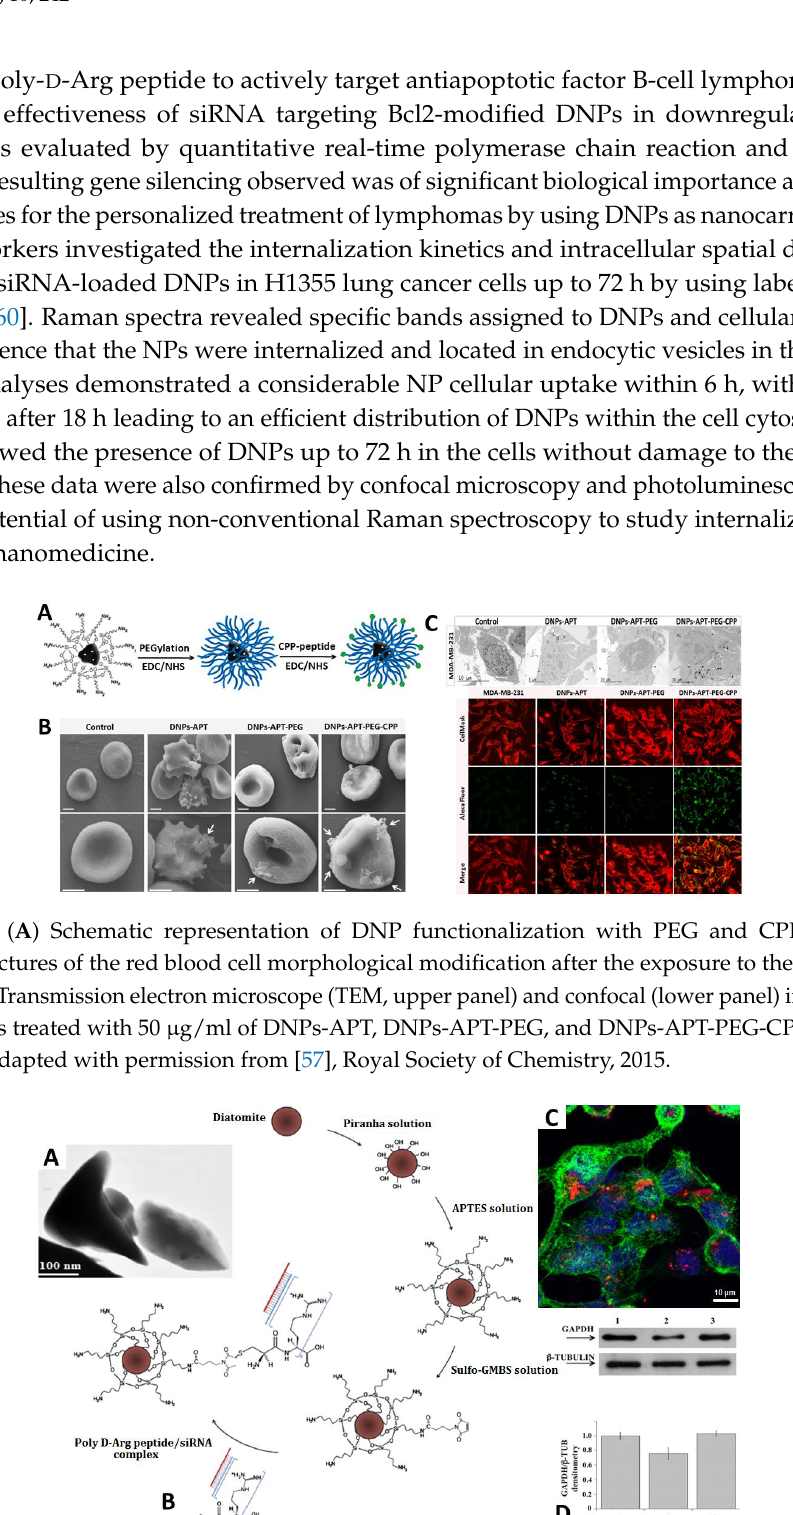
Figure 5. ( A ) Transmission electron microscope (TEM) images of diatomite NPs (DNPs). ( B ) Schematic representation of DNP functionalization with siRNA. ( C ) Representative confocal microscopy image of cells treated with Dy547-labelled siRNA-DNPs for 12 h at 37 °C. Cell nuclei and membranes were stained with Hoechst 33342 and WGA-Alexa Fluor 488, respectively. ( D ) Immunoblotting analysis of GAPDH (upper gel) and of β -tubulin (lower gel) of protein expression in DNPs-siRNA treated cells. Lanes: (1) control cells, (2) DNPs-GAPDH-siRNA, and (3) DNPs-SCR-siRNA. Adapted with permission from [38], Elsevier,